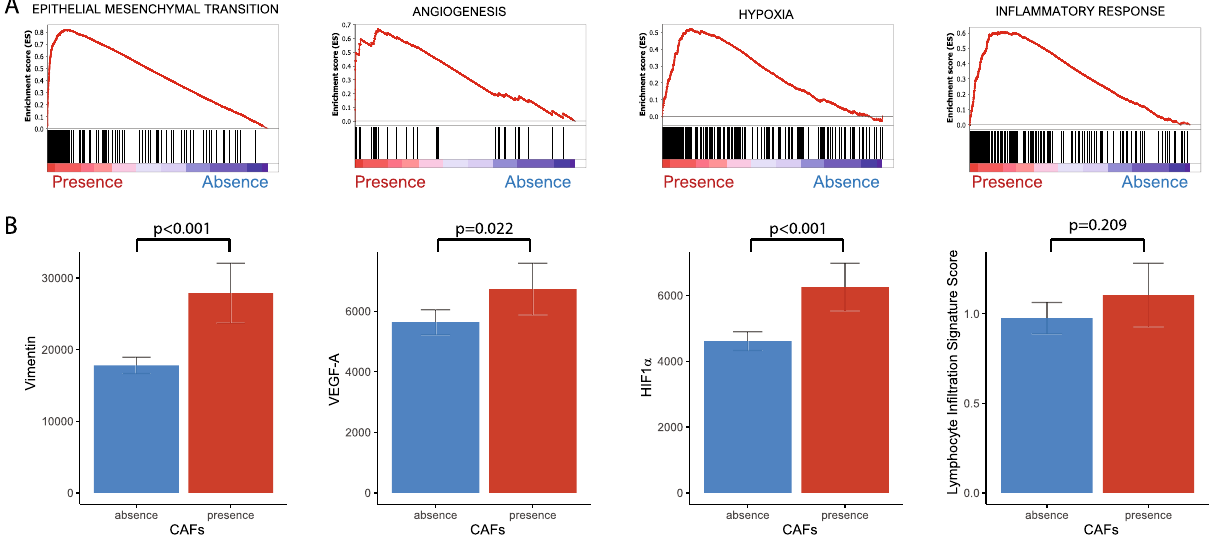
Figure 2. ( A ) Four gene sets (the epithelial-mesenchymal transition, angiogenesis, hypoxia, and inflammatory response gene sets) associated with cancer-associated fibroblasts. ( B ) Bar plots of the relationships between cancer-associated fibroblasts and markers of the identified gene sets: vimentin, vascular endothelial growth factor-A (VEGF-A), hypoxia inducible factor 1 subunit alpha (HIF1α) and lymphocyte infiltration signature score ( p < 0.001, = 0.022, < 0.001 and = 0.209, respectively).